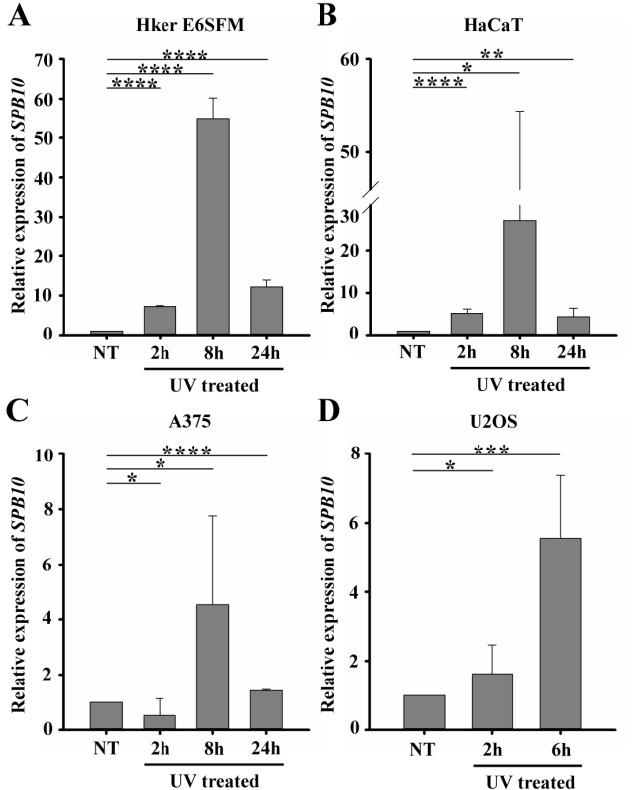
Figure 1. UV irradiation triggers elevation of SPB10 mRNA: Relative expression levels of SPB10 gene in ( A ) Hker E6SFM keratinocyte, ( B ) HaCaT keratinocyte, ( C ) A375 melanoma, and ( D ) U2OS osteosarcoma cells analyzed by qPCR. Data were normalized to 18S RNA and compared to control (NT). Means and standard deviations of three independent experimental triplicates are indicated as fold changes. Asterisks indicate statistical significance between datasets ( t -test, * p ≤ 0.05, ** p ≤ 0.01, *** p ≤ 0.001, **** p ≤ 0.0001).